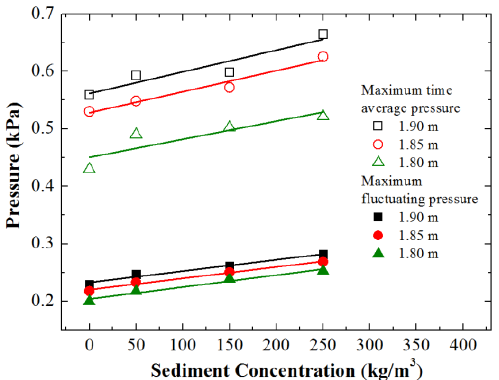
Figure 9. Relationship between pressures and sediment concentrations for different upstream water heads.